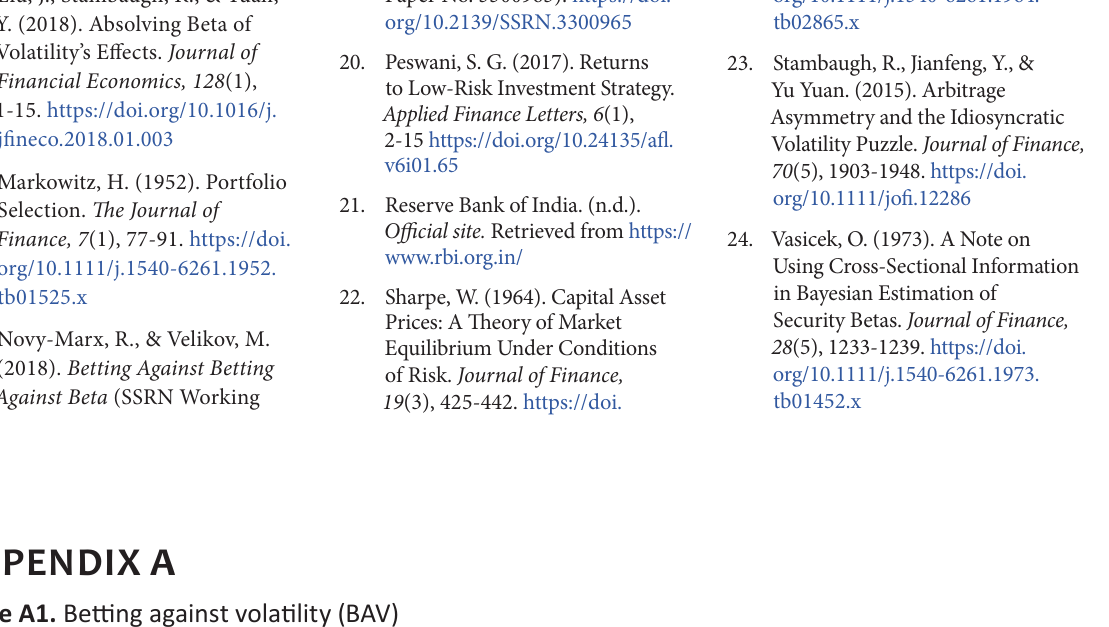
Table A1. Betting against volatility